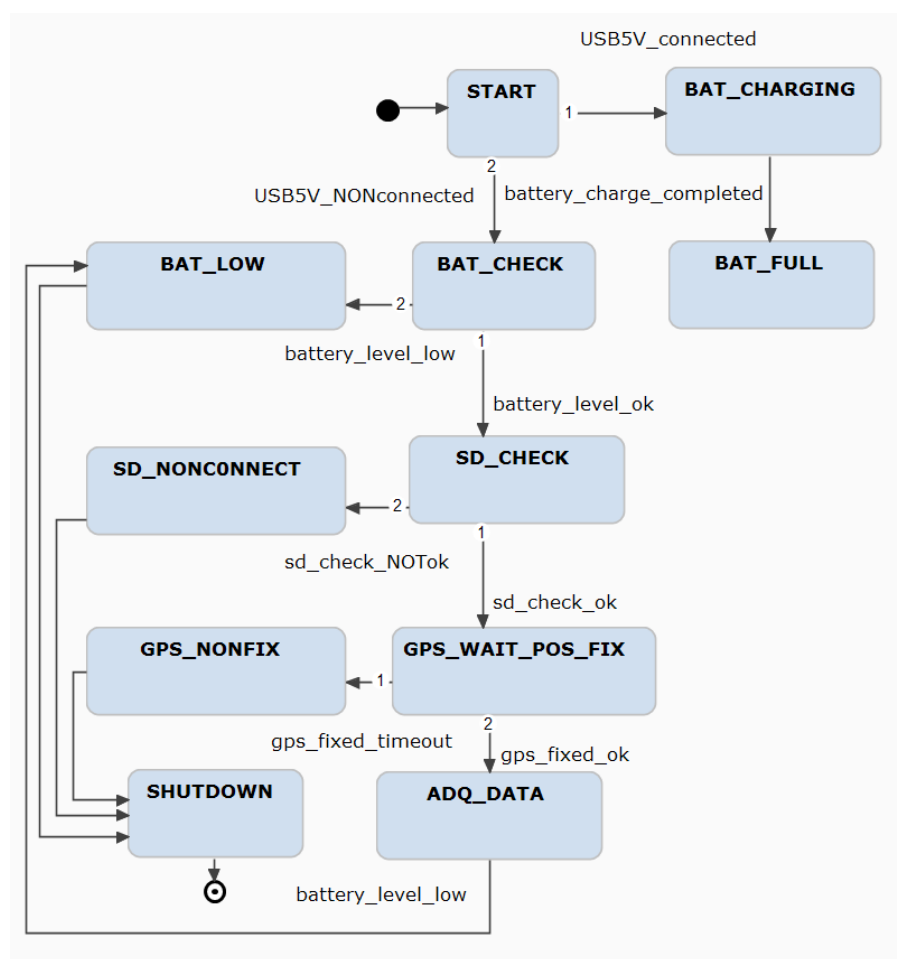
Figure 4. State machine reduced diagram created with Yakindu StateChart Tools (https://www. itemis.com/en/yakindu/state-machine/ (accessed on 25 March 2023)). It is operated by the different OS tasks and changes its behavior based on the current